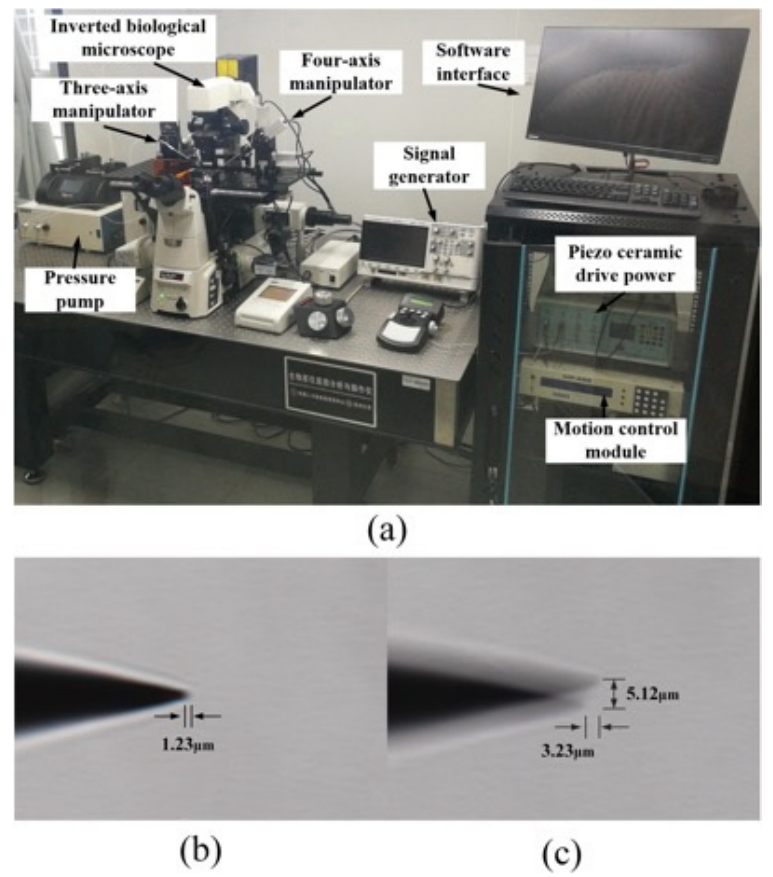
Figure 8. Dissecting needle tip vibration test: ( a ) The experiment platform; ( b ) the vibration of the microdissection device with flexure mechanism when the lateral vibration is minimal; ( c ) the vibration of traditional microdissection device when lateral vibration is minimum.